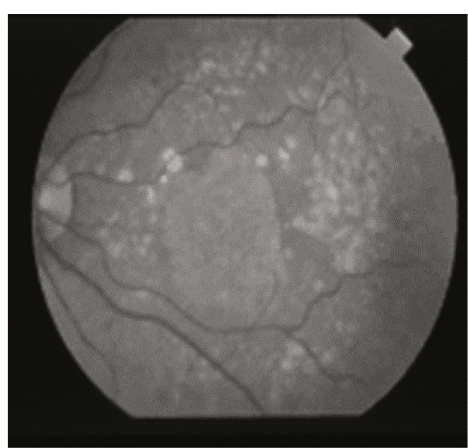
Figure 3: Gray scale image.